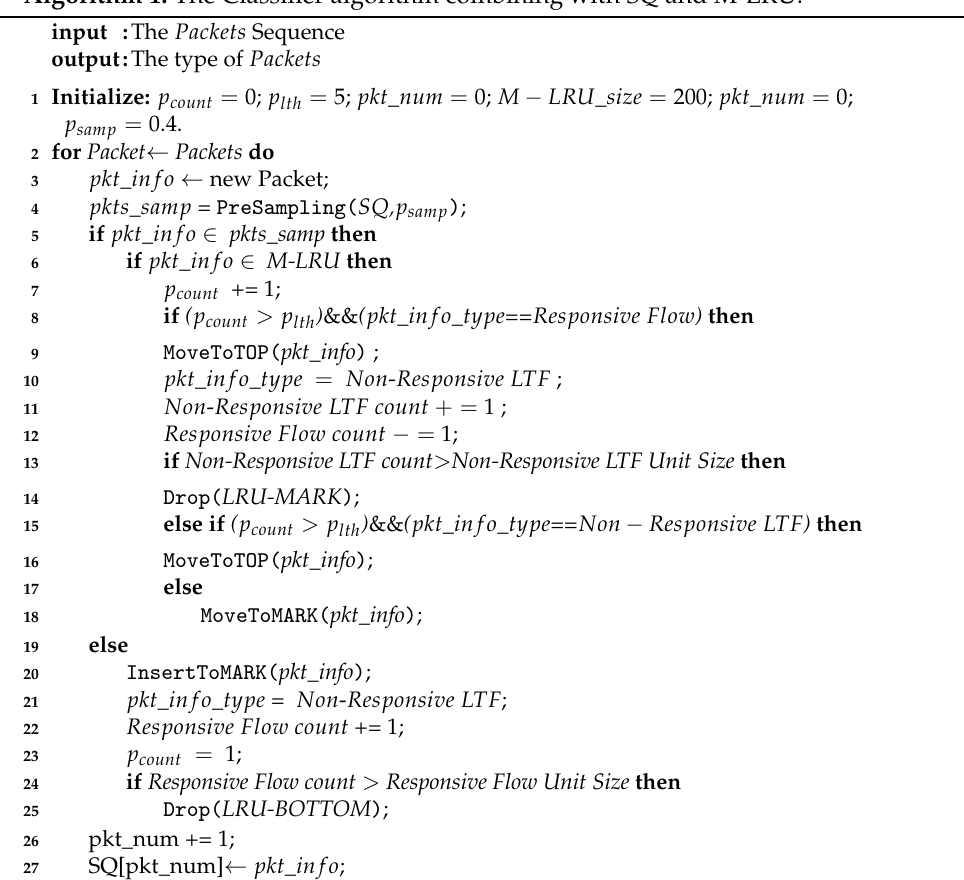
Figure 8. Combine SQ and M-LRU for flow detection. Algorithm 1: The Classifier algorithm combining with SQ and